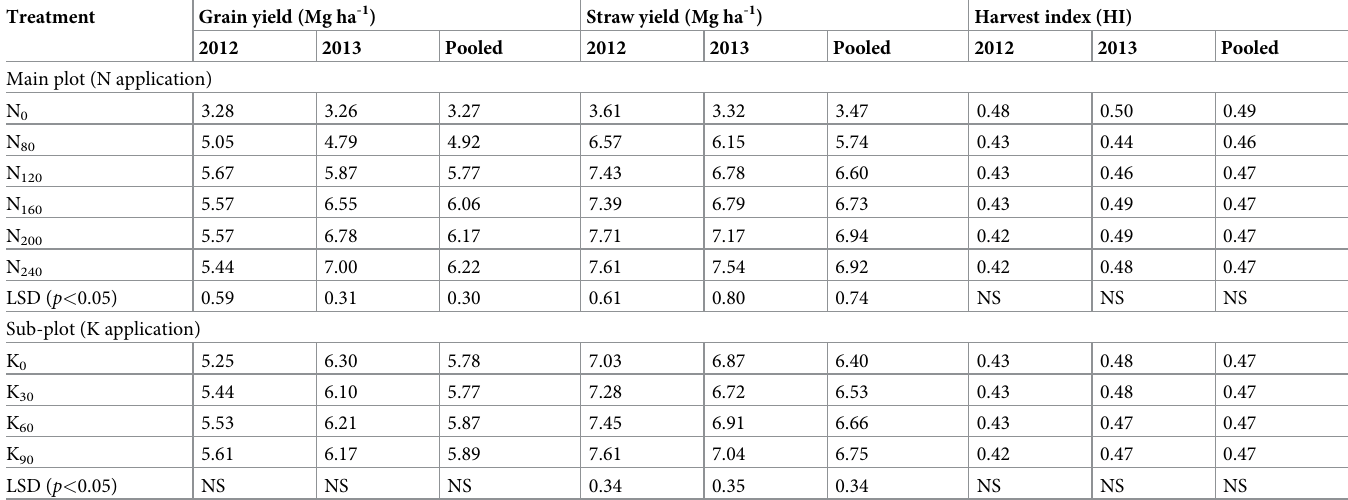
Table 2. Effect of nitrogen (N) and potassium (K) application on wheat grain, straw yield (Mg ha -1 ) and harvest index in a sandy loam soil in sub-tropical India. Treatment Grain yield (Mg ha -1 ) Straw yield (Mg ha -1 )